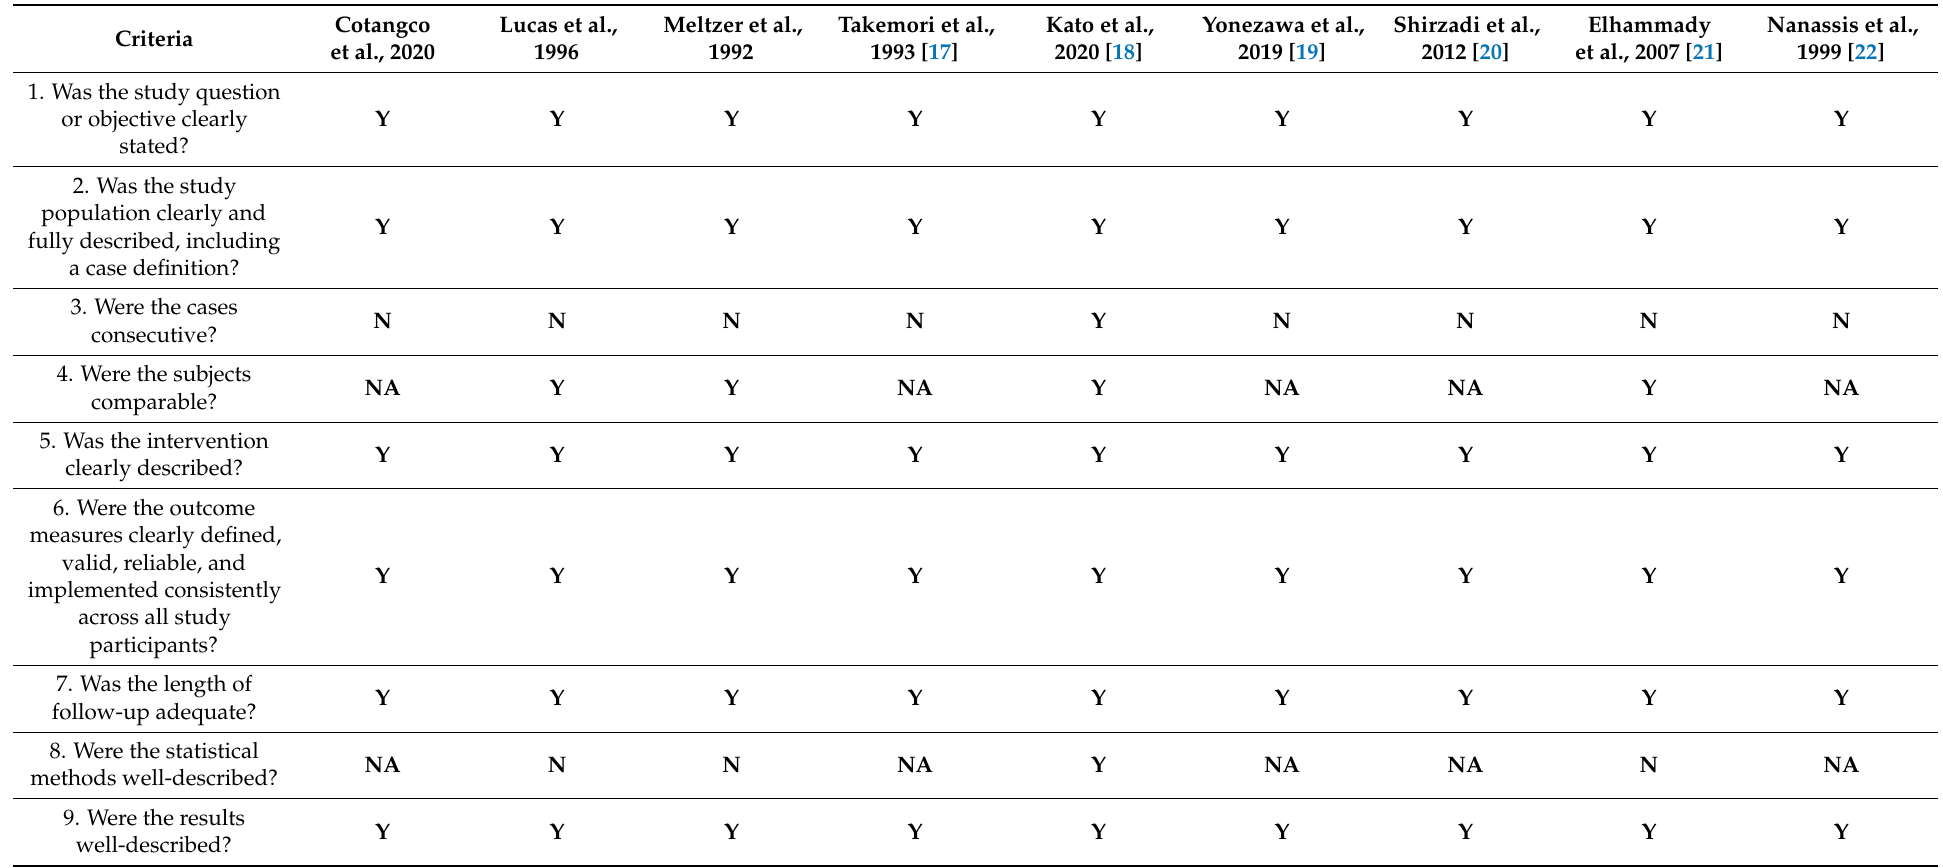
Table 5. Assessment of methodological